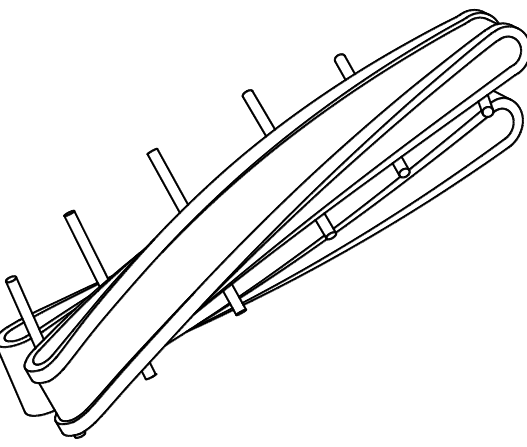
Figure 7. Rape shoot stalk transport status.